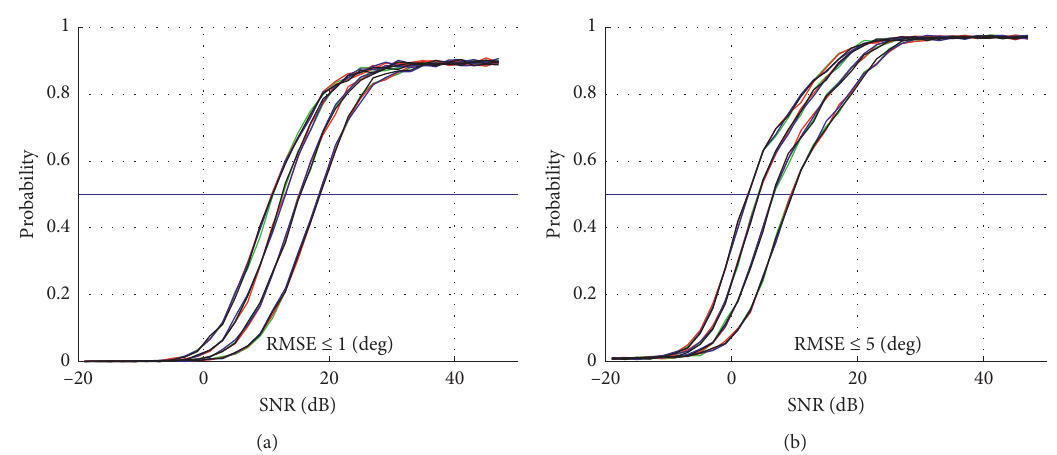
Figure 14: Probability of AoA estimation of Array-3 for 4 waveforms with M + 1 � 2 , 3 , 5 , and 9, from right to left in each